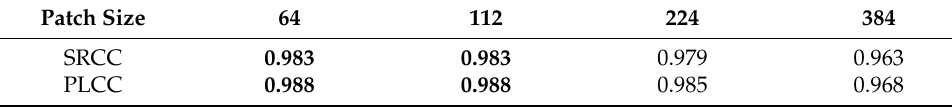
Table 3. Comparison of the SRCC and PLCC with different patch